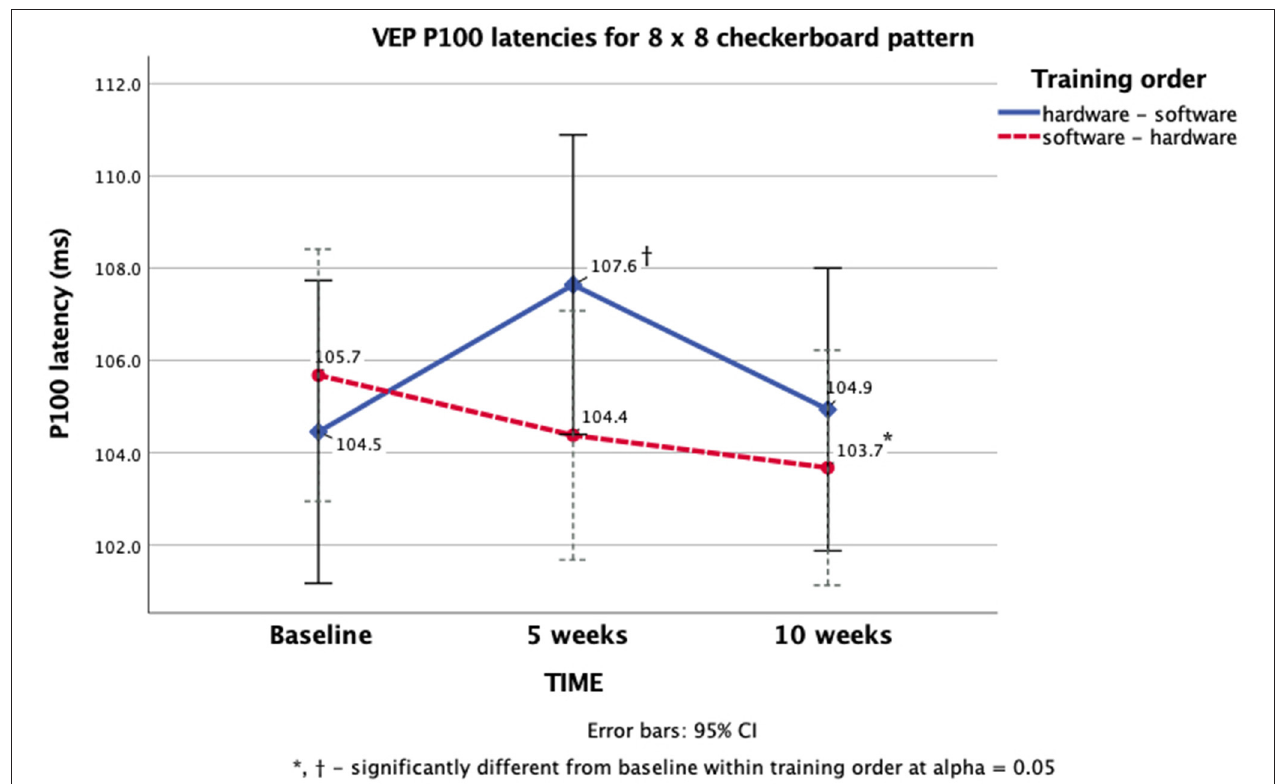
FIGURE 4 | VEP P100 latency differences within training order for the 8 × 8 checkerboard pattern.